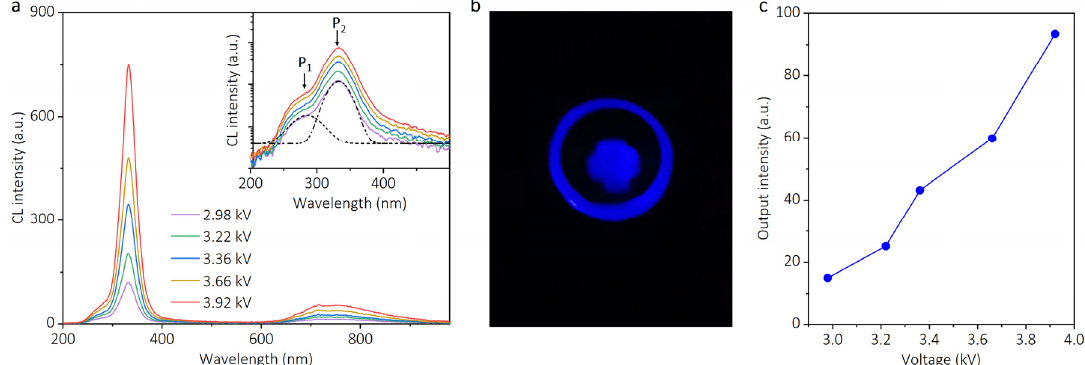
Figure 5. Luminescence properties of the ultraviolet device. ( a ) The output spectra of the device at various excitation voltages. The inset displays a semi-logarithmic plot of the output spectra in the short-wavelength region, with two Gaussian fit peaks marked as P 1 and P 2 . ( b ) A photograph of the device taken by an ultraviolet-sensitive camera while it is in operation. ( c ) The variation of output intensity with excitation voltage.